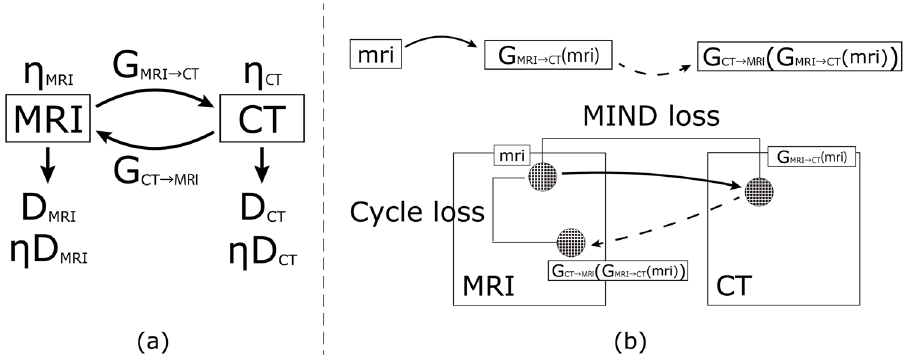
Figure 1. Outline of proposed U-GAT-IT + MIND process (G, D, and η denote generator, discriminator, and auxiliary classifier, respectively). We introduce Cycle loss, which is a comparison within the same domain after two rounds of transformation; this is in addition to MIND loss, which is a comparison between different domains after one round of